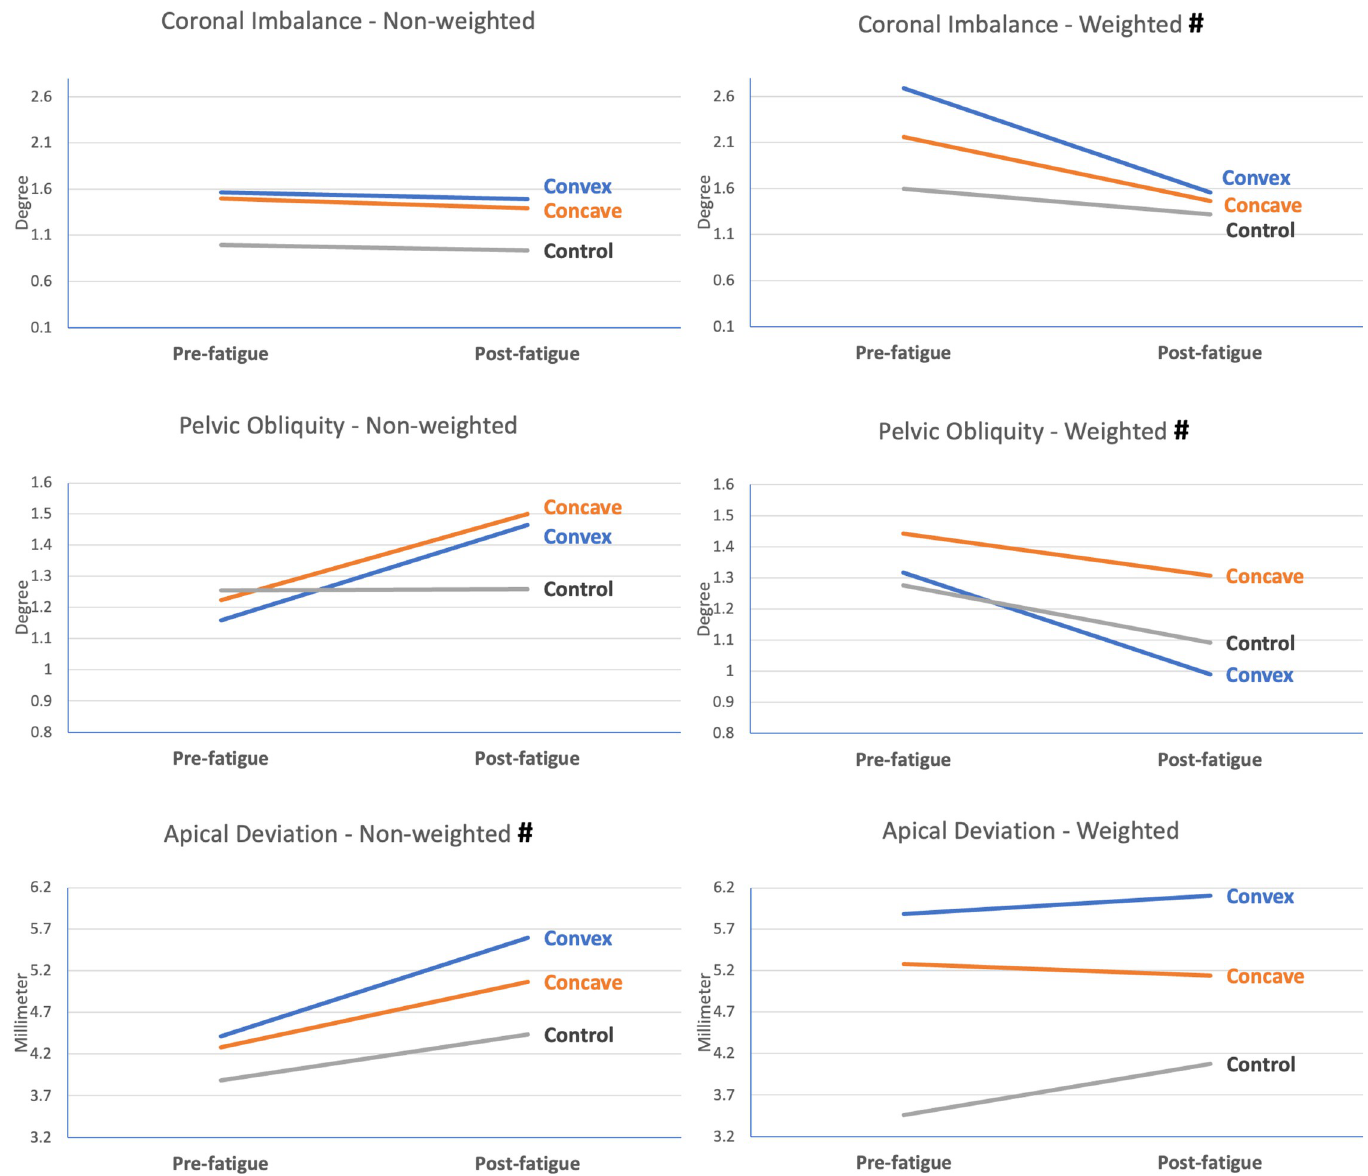
Fig 7. Coronal-plane spinal kinematics during weighted and non-weighted functional tasks at pre- and post-fatigue. # represents significant time effect between pre- and post- fatigue measurement (p < 0.05); � represents significant time-and-group interaction between the indicated side and control group (p < 0.05).